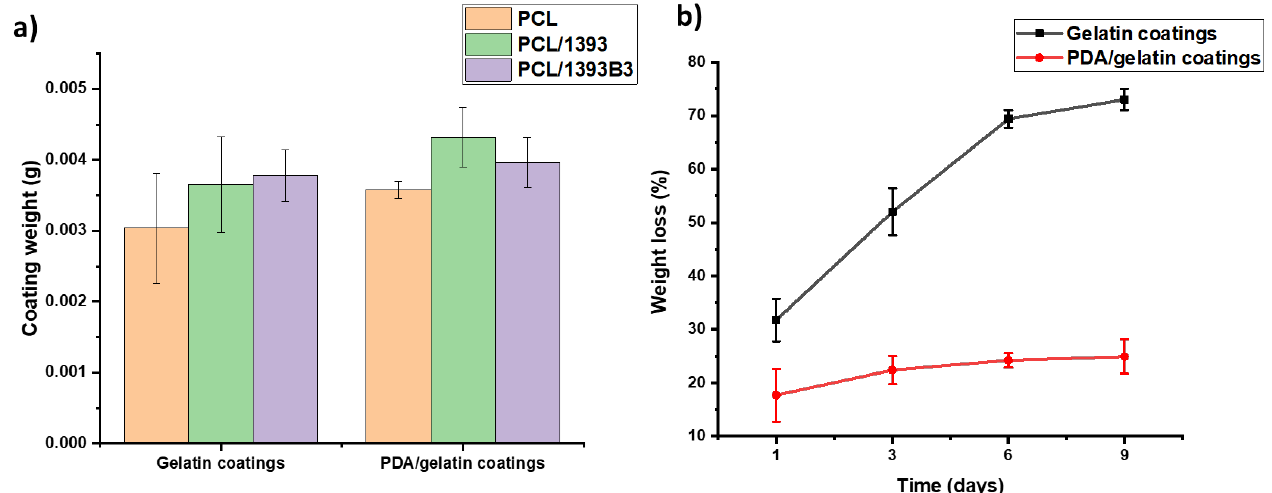
Figure 3. In vitro degradation; ( a ) weight of coatings; ( b ) degradation of different coated scaffolds soaked in DPBS solution for 9